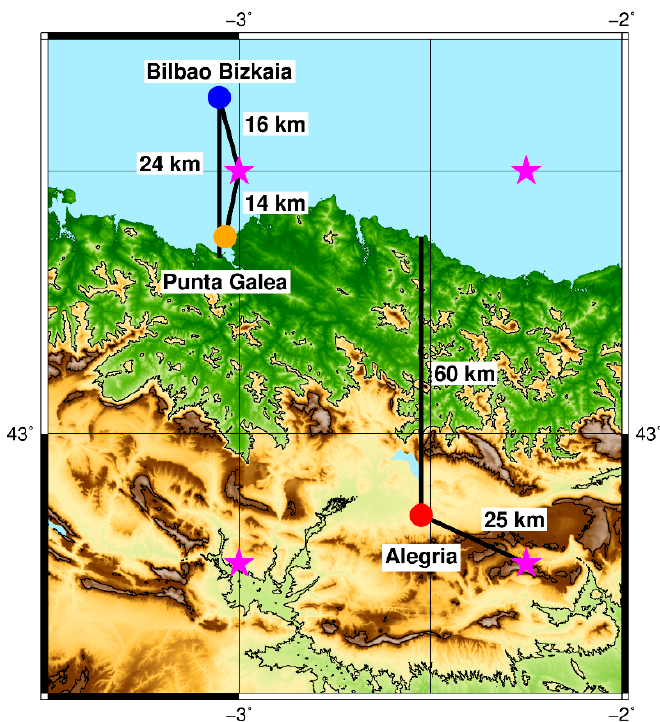
Figure 1. Locations of interest, Bilbao Bizkaia buoy (blue circle), Punta Galea station (orange circle), Alegria station (red circle). Distances in km to the nearest ERA-Interim node (magenta star) and from the coast to the Bizkaia buoy.